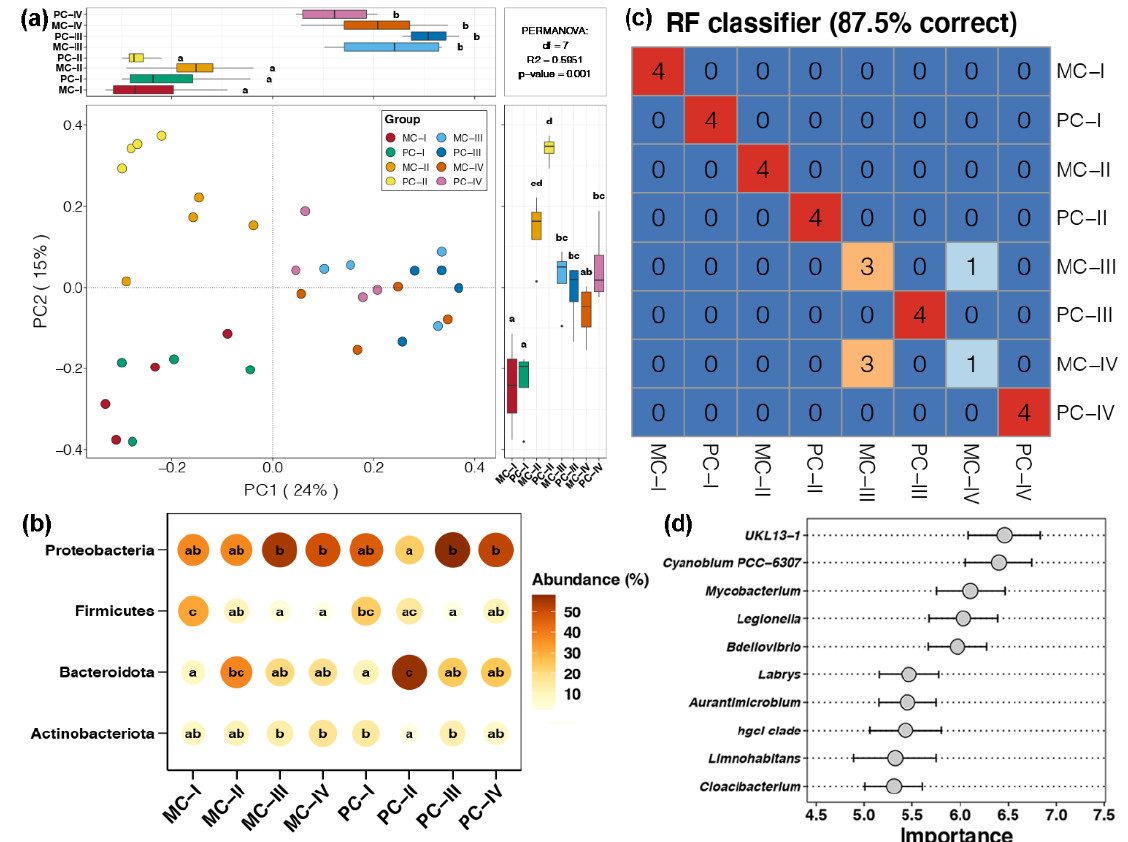
Figure 1. Variation in bacterioplankton communities with culture stage and apex predator disturbance. ( a ) Principal coordinate analysis (PCoA) and PERMANOVA of bacterioplankton communities among different culture stages with and without apex predators. Boxplots (top and right) represent sample distributions from different groups on PC1 and PC2 axes, respectively. Different lowercase letters above each box in the same sub-Figure represent significant differences between groups (Tukey’s HSD test, p < 0.05). ( b ) Differences in the relative abundance of dominant bacterial phyla among different groups. The size of points represents the relative abundance of different bacterial phyla, and different lowercase letters on the internal side of points from the same row represent significant differences between groups (Tukey’s HSD test, p < 0.05). ( c ) Accuracy of the random forest model for distinguishing sample groups. Numbers on the diagonal represent the number of samples in which the results predicted by the random forest model are consistent with the actual results. Numbers in other cells represent the number of samples in which the name of the row is their actual region, but the random forest model predicts them as belonging to the region indicated by the name of the column. ( d ) Importance of key genera identified by the random forest model in distinguish sample